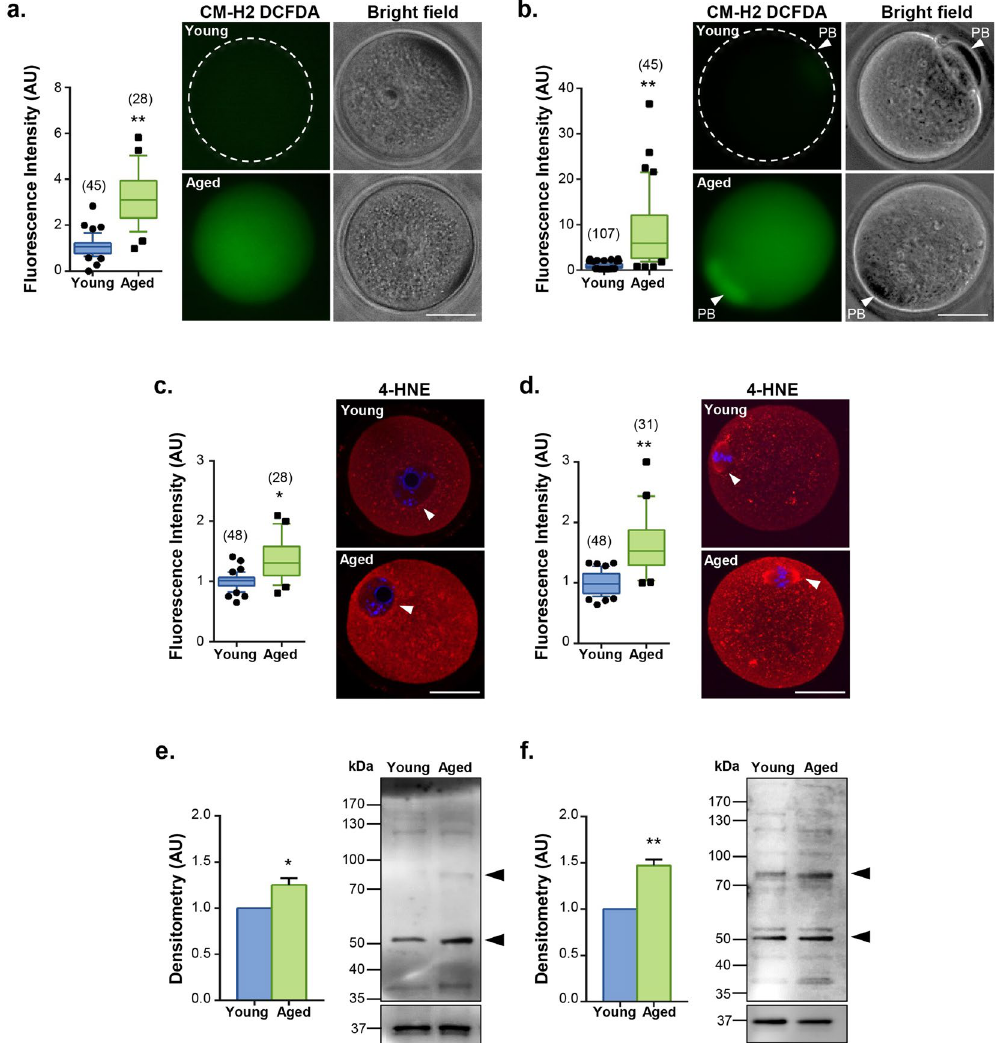
Figure 1. Oocytes from aged mice carry a higher oxidative burden and have an increase in 4-HNE accumulation. GV oocytes were collected from un-primed young animals (4 to 6 weeks) and aged animals (14 months) or underwent IVM to MII. ( a ) GV and ( b ) MII oocytes from aged animals displayed elevated levels of cytosolic ROS as indicated by labelling with the CM-H2 DCFDA probe (green). White arrows indicate the polar body (PB). Scale bar = 20 μ m. ( c ) An increase in the accumulation of 4-HNE was detected using immunocytochemistry against 4-HNE (red) in both GV and ( d ) MII oocytes. White arrows indicate the nuclear envelope and spindle, respectively. Nuclei were counterstained with Hoechst (blue). Scale bar = 20 μ m. Box and whisker plots show means as the centreline, box as the 25–75th percentiles and whiskers as the 10–90th percentiles. Ageing assays were performed with n = 4 mice, with each mouse contributing a minimum of 7 oocytes and representing an independent technical replicate. ( e ) An increase in the 4-HNE adduction in aged oocytes was also confirmed via 4-HNE immunoblotting, which revealed an increase in the band intensity of the majority of 4-HNE modified proteins in aged GV and ( f ) MII oocyte lysates. Black arrows indicate the predominate proteins at approximately 80 and 55 kDa. For all samples, the pixel intensity of the entire lane was analysed by densitometry. Immunoblots were stripped and re-probed with GAPDH as a loading control. Error bars represent SEM. Statistical analyses were performed using Student’s t-test, * p ≤ 0.05 and ** p ≤ 0.01. Immunoblots were performed in biological and technical triplicate using 100 oocytes per lane pooled from a minimum of 3 young animals and between 12 to 15 aged